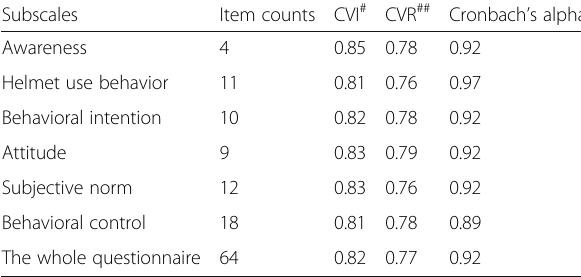
Table 1 Results of validity and reliability of the whole questionnaire and its